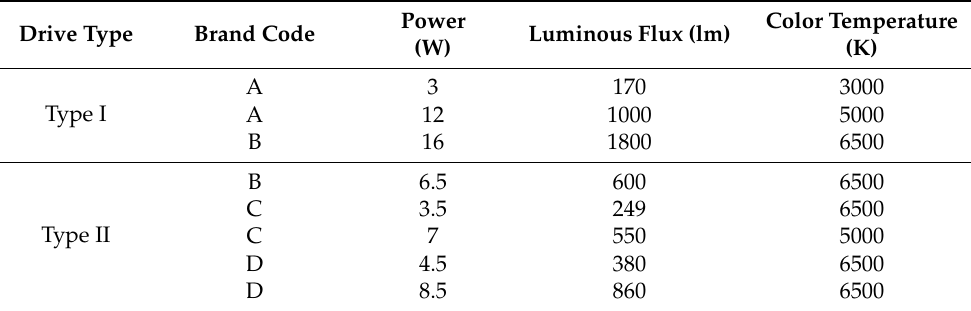
Table 2. Performance index parameters of the test LED lamp.